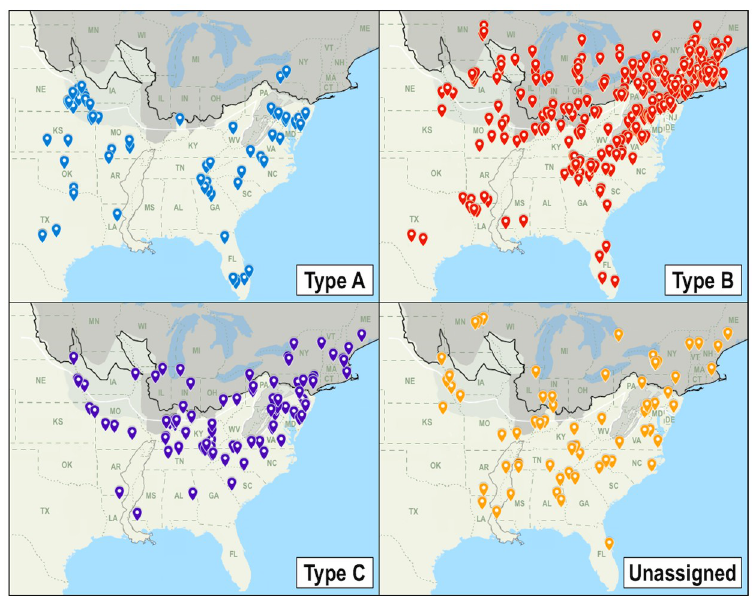
Fig 7. Mapped locations of all analyzed singers displayed by category with glacial environment. Comparison of the distributions of the four designated categories with former glacial conditions. Pre-Illinoian glacial maximum is represented by a light gray screen, Illinoian glacial maximum and high-altitude periglacial permafrost are represented by dark gray screens, the Last Glacial Maximum boundary is indicated by a black line and accompanying permafrost boundary by a white line, and a gray outline represents the Mississippi